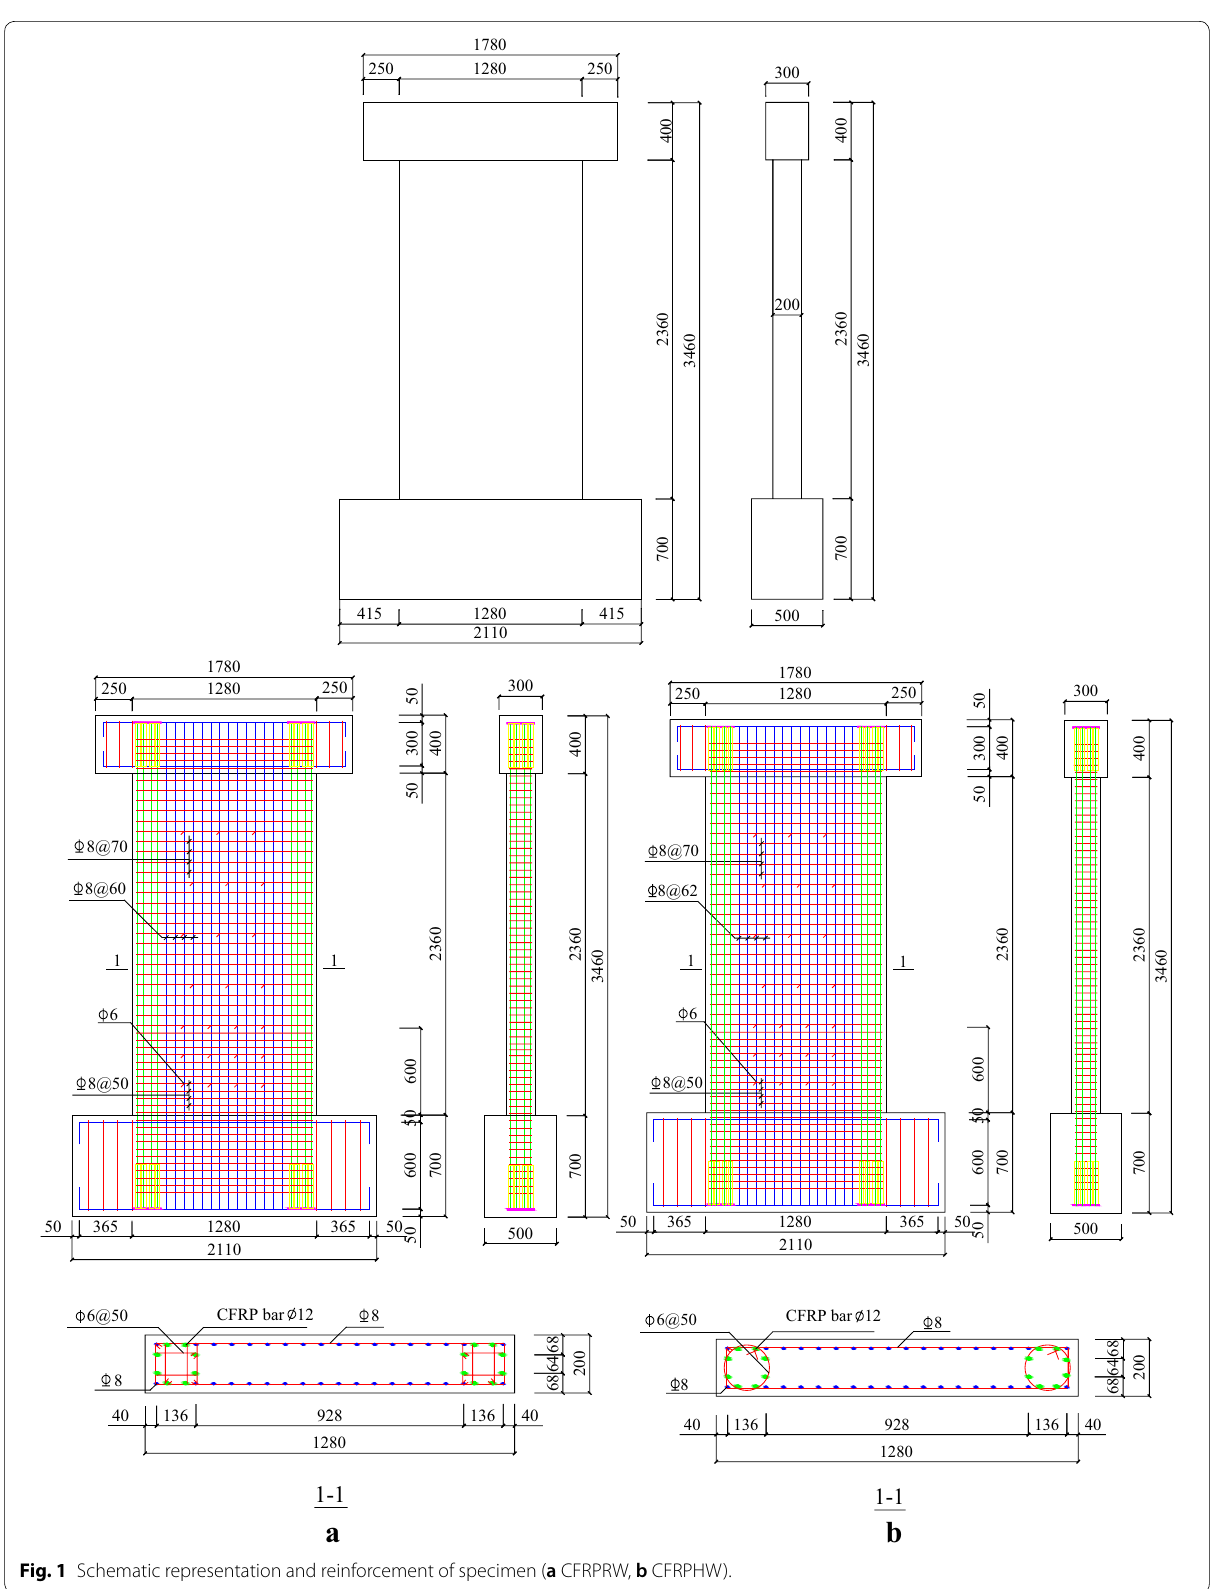
Fig. 1 Schematic representation and reinforcement of specimen ( a CFRPRW, b